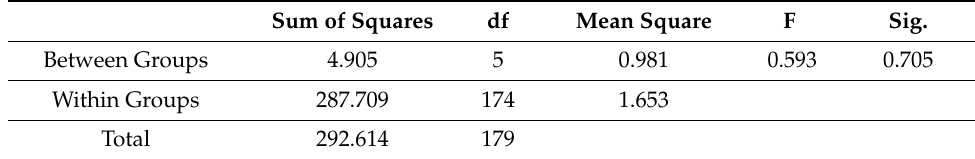
Table 6. One-way ANOVA test on the 50-PHEV dataset.